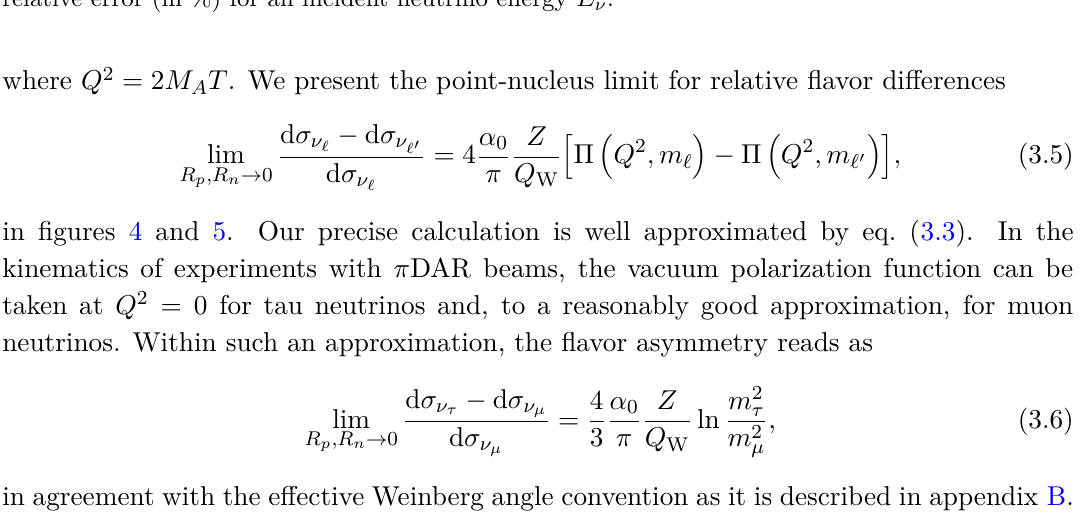
) /σ in % , on 40 Ar target and contributions to the − σ ν ν µ τ µ ν